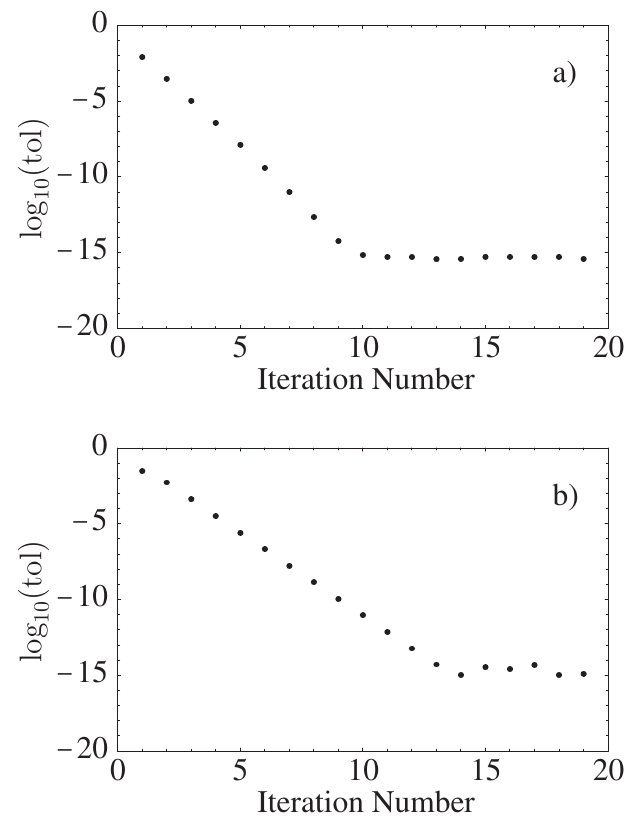
FIG. 5. Log of fractional error tolerance ( tol ) achieved for matched envelope solutions versus number of IM iterations for (a) solenoidal and (b) FODO ( (cid:7) (cid:2) 1 = 2 ) quadrupole focusing lattices. Solutions are generated using case 2 methods for system (cid:2) 0 : 5 m , (cid:9) (cid:2) 0 : 5 , (cid:6) (cid:2) 80 (cid:10) , " (cid:2) 50 mm mrad , parameters: L p 0 (cid:2) 0 : 2 [corresponding to Q ’ 6 : 700 (cid:9) 10 (cid:1) 4 and Q and (cid:6)=(cid:6) 0